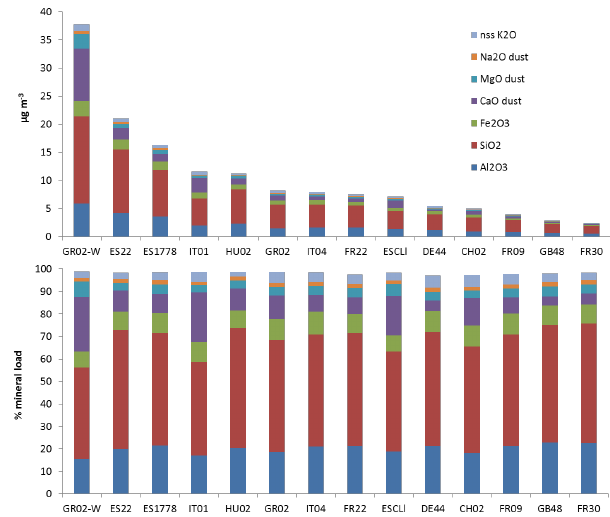
Figure 10. Average concentration of mineral dust components (ab- solute values – µgm − 3 , top) and the relative contribution of com- ponents (%, bottom) in mineral dust at selected sites when affected by African dust episodes. Results from both summer and winter (GR02-W) IMPs are